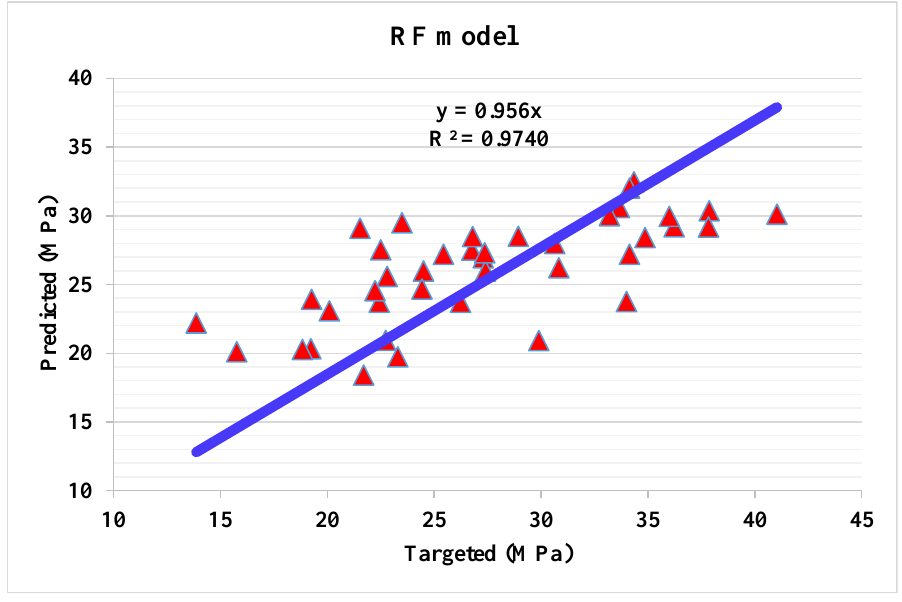
Figure 12. Predicted and actual results for RF model.